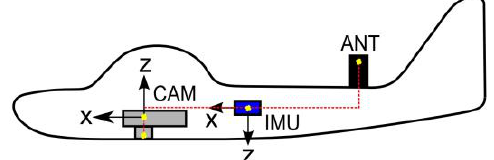
Figure 4. Schematic sketch of the sensor offsets between the camera instrumental frame, IMU-sensor frame and GNSS antenna